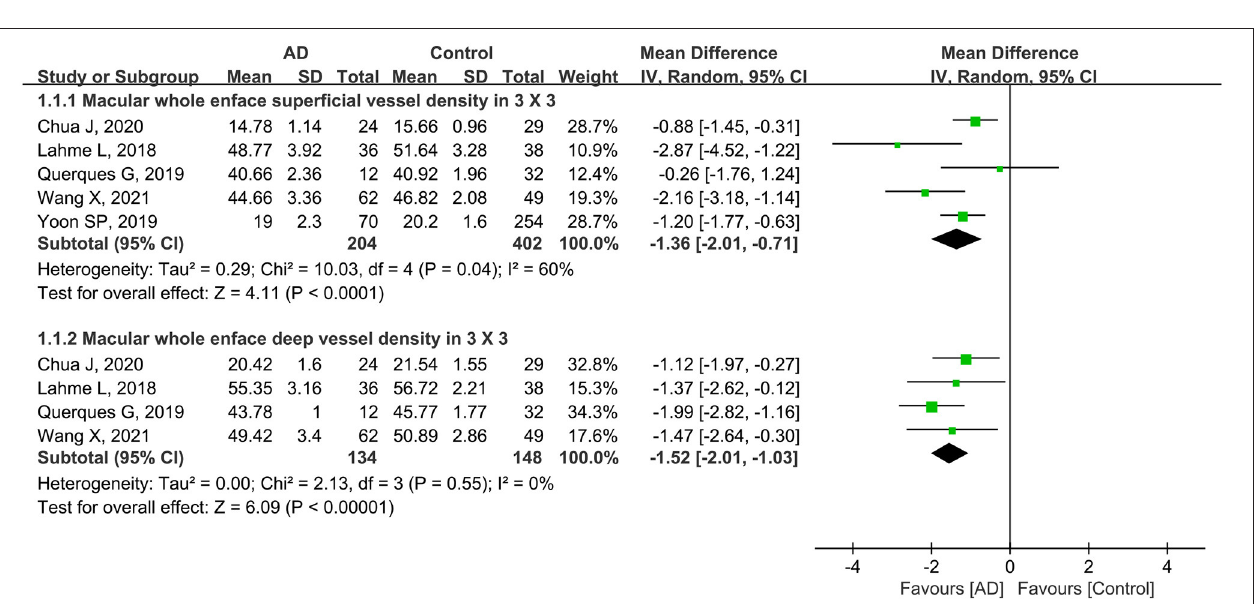
showing minimal heterogeneity (chi 2 = 0.76, P = 0.38, I 2 = 0%, Figure 6